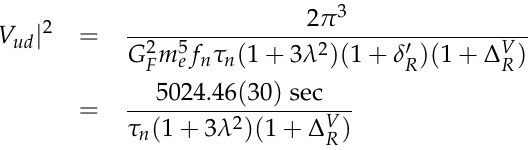
Table 2. Using the neutron β -decay lifetime of τ n = 888.2 ± 2.0 s from the averaged “beam”